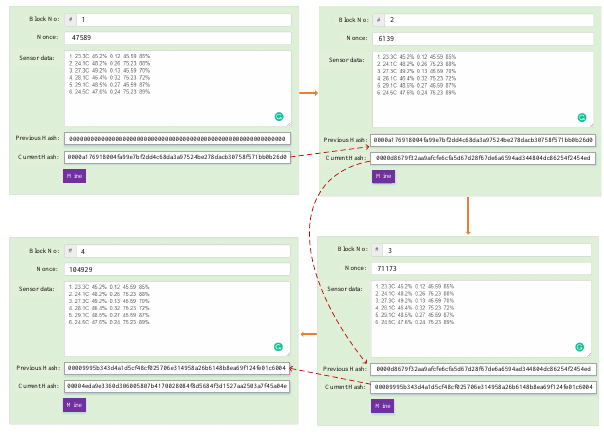
Figure 11. Result when normal